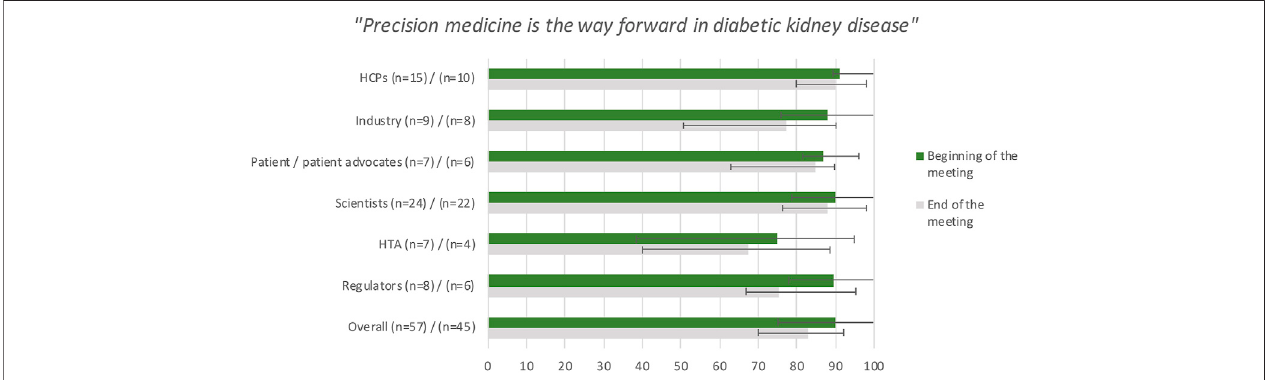
FIGURE 2 | Median and interquartile range of the answers per stakeholder group to the question “ How much do you agree with the statement below: Precision medicine is the way forward in Diabetic Kidney Disease? ” on a Visual Analogue Scale ranging from 0 (disagree) – 100 (agree) at the beginning and the end of the two-day meeting. (HCP, healthcare professional; HTA, health technology